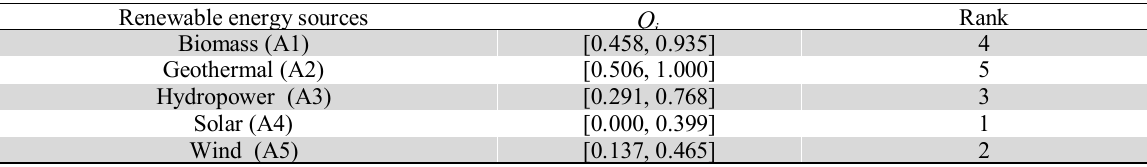
Rating of Q and ranking of renewable energy sources i